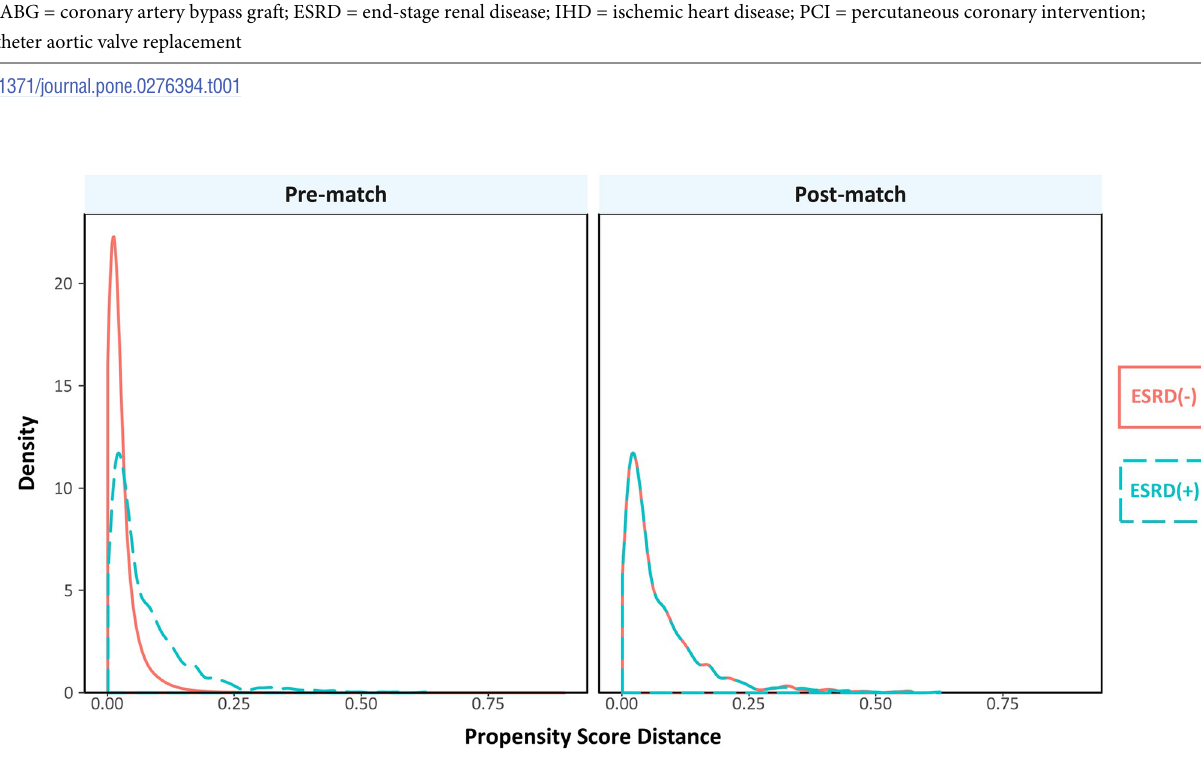
Fig 2. Overlap plot for propensity score. Overlap plot for the estimated density of the propensity score distances among patients undergoing TAVR with versus without co-diagnosis of ESRD.